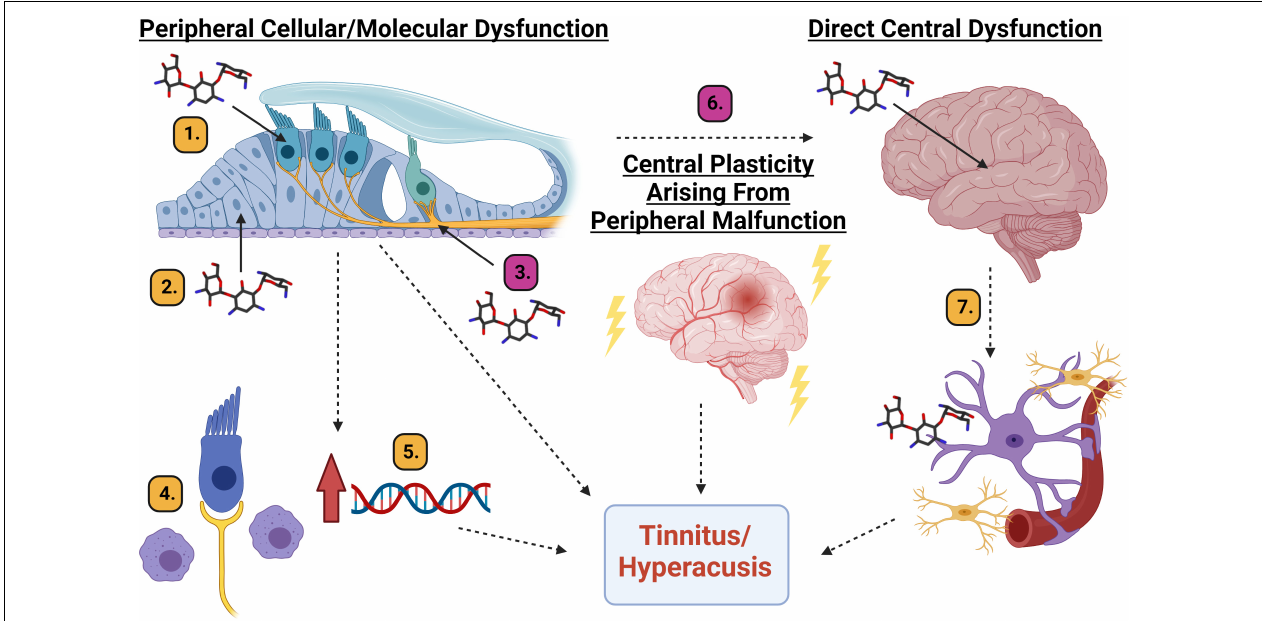
FIGURE 7 | Diagram of potential mechanistic explanations for AG-induced tinnitus and hyperacusis. Peripheral cellular or molecular dysfunction: (1). Hair cell cellular dysfunction. (2). Supporting cell dysfunction. (3). Spiral ganglion neuron/synapse dysfunction. (4). Inflammation induced macrophage activation. (5). Upregulation of genes responsible for inflammation. Central plasticity arising from peripheral malfunction. (6). Changes in the neural code related to maladaptive plastic changes to the auditory system. Direct central dysfunction. (7). Aminoglycoside crossing the blood brain barrier leading to inflammation and cellular/molecular responses from microglia and astrocytes which can result in changes to neural firing patterns. Magenta # mechanisms are partially supported by data from this manuscript and Longenecker et al., 2020. Yellow # mechanisms require further scientific exploration. Created with BioRender.com.